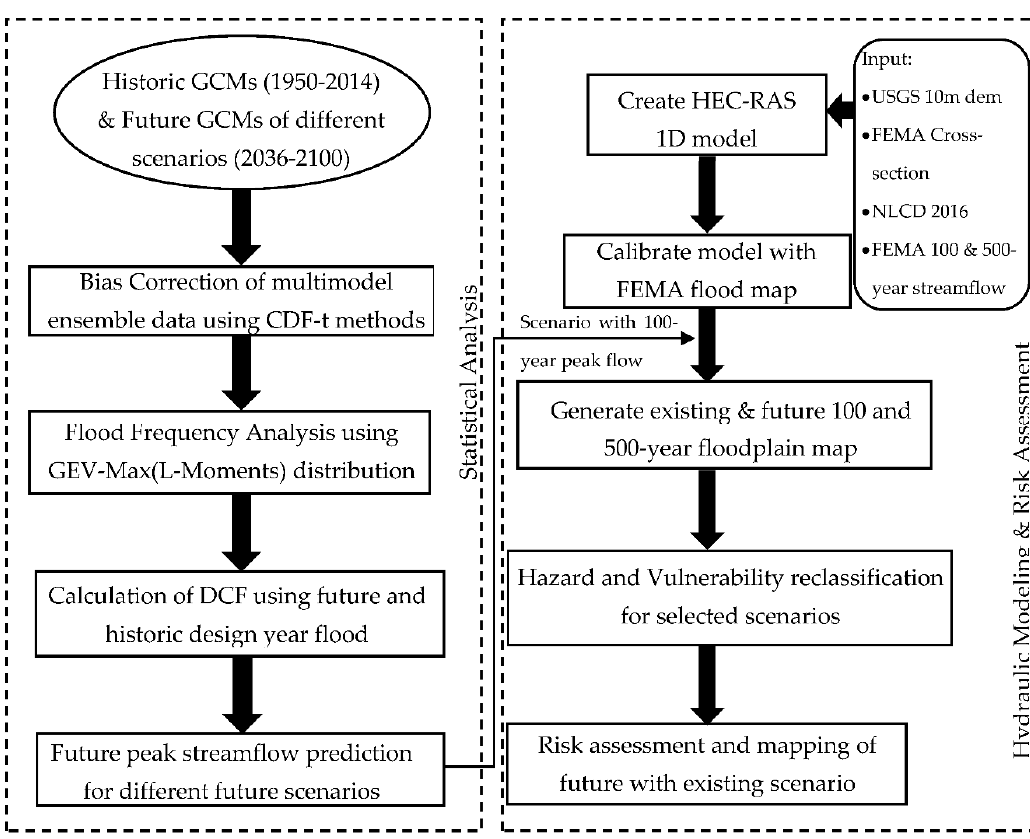
Figure 2. Schematic diagram showing the sequential steps followed to analyze flood frequency, predict the future streamflow, flow routing, floodplain mapping, and risk